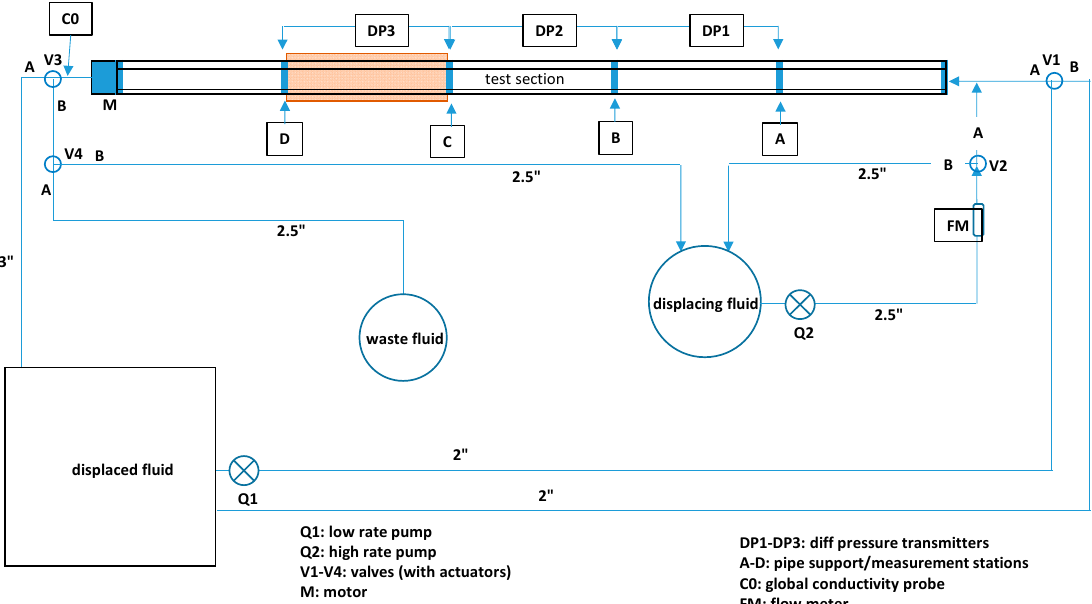
Figure 2. Process and instrumentation diagram for the flow rig. Note that probe C0 and valve V3 were positioned about 9.5 m downstream of the test section exit point.